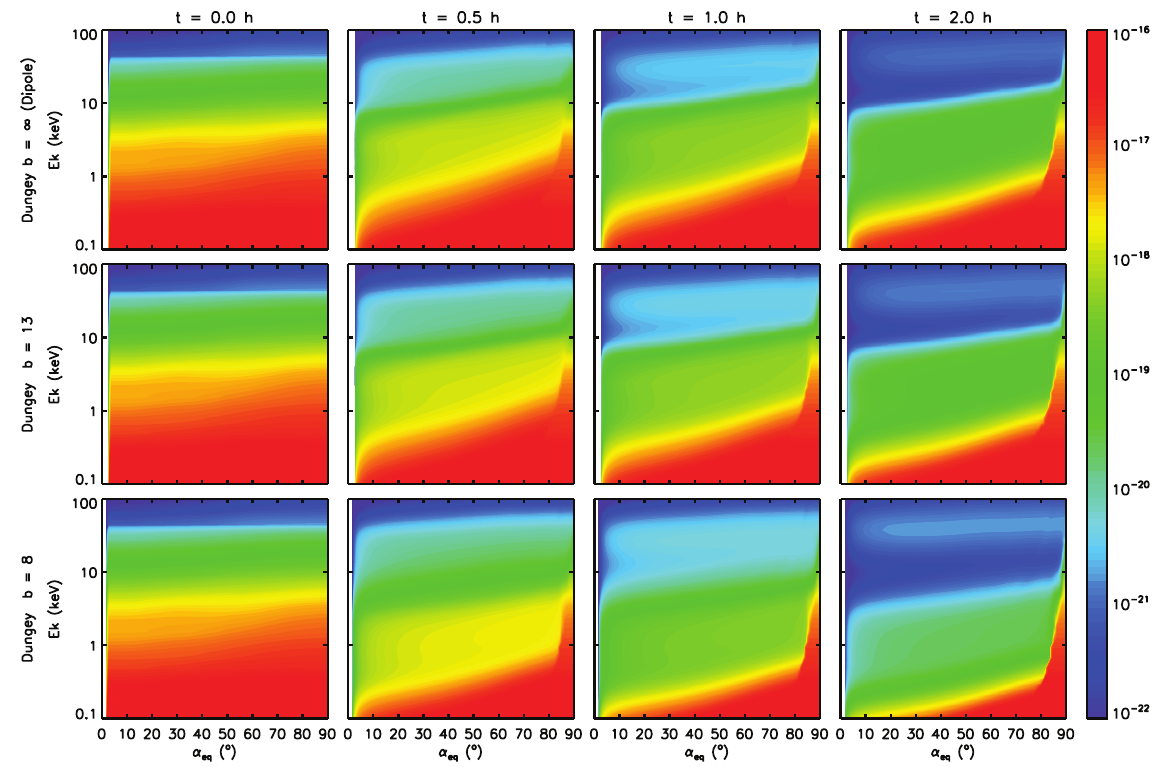
Fig. 4. Evolution of electron PSD (in units of s 3 m − 6 ) as a function of equatorial pitch angle and kinetic energy due to nightside chorus at L = 6 from initial condition (column 1) to t = 0 . 5h (column 2), t = 1 . 0h (column 3) and up to t = 2 . 0h (column 4) in the Dungey magnetic models with b =∞ (dipole), 13 and